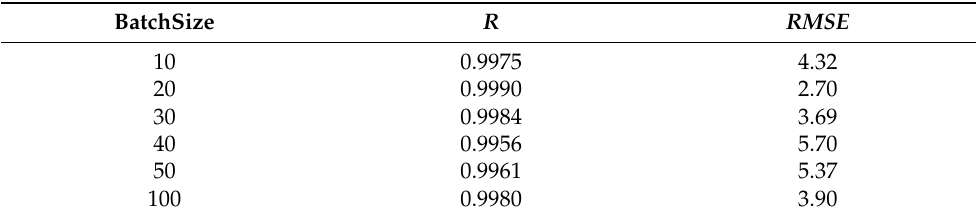
Table 4. The effect of Batchsize on the model.